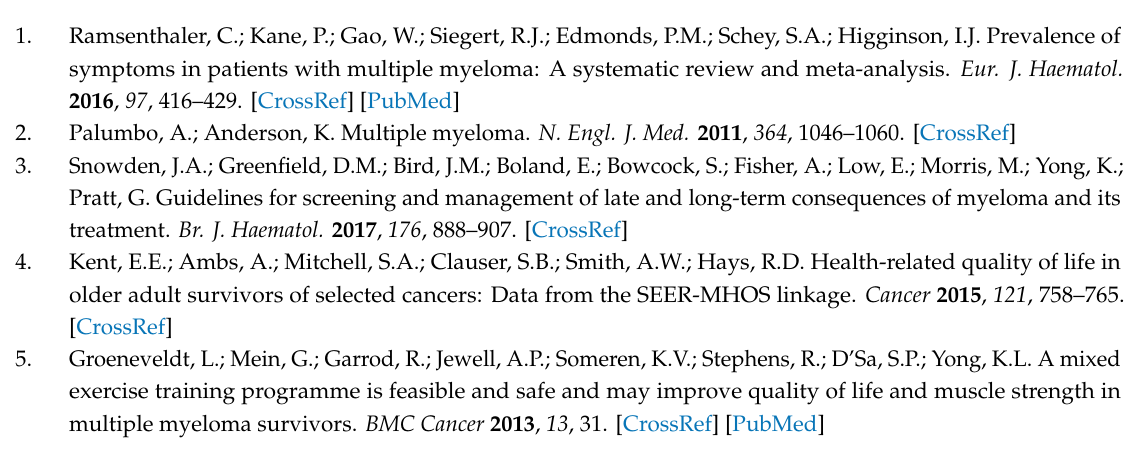
Table S1: Survey responses for symptoms experienced by respondents during the previous month; Table S2: Survey responses for respondents for frequency of receiving physical activity and exercise advice from healthcare professionals; Table S3: Survey responses by respondents for frequency of recommendations to see an exercise specialist for physical activity and exercise advice; Table S4: Survey responses by respondents for preferences for an exercise program for people with multiple myeloma; Table S5: Survey responses by respondents for components of an exercise program for people with multiple